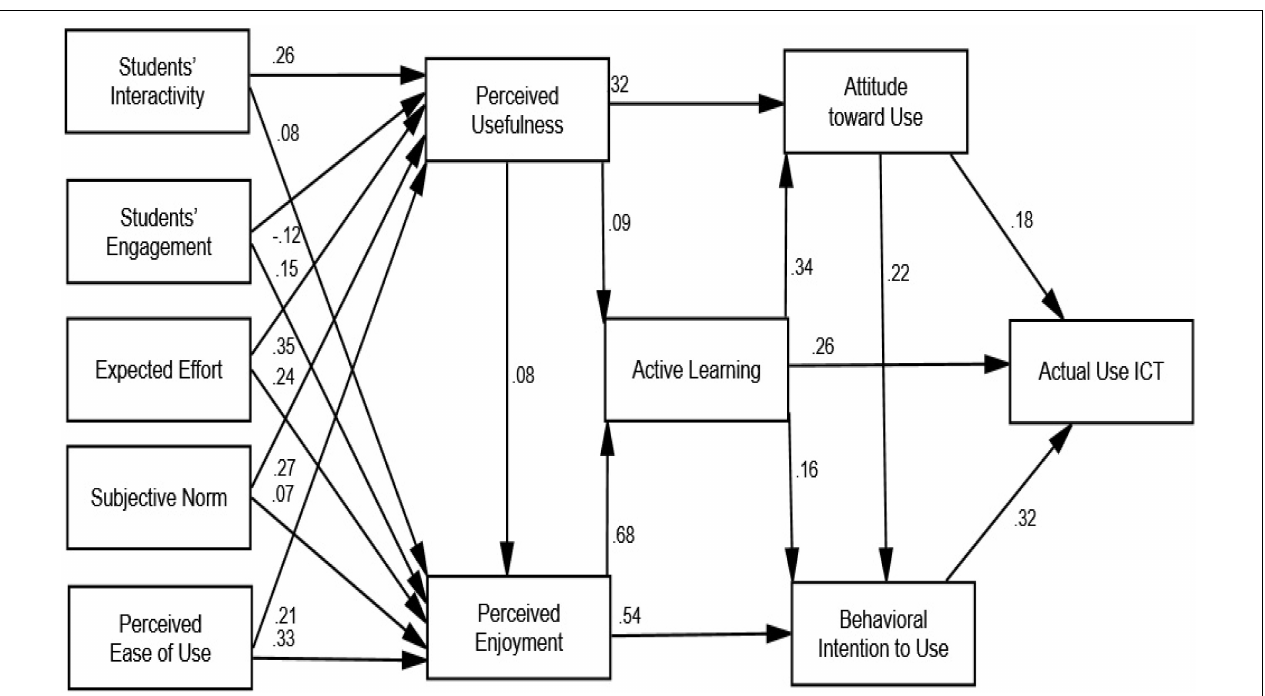
FIGURE 4 | Path T -values results.